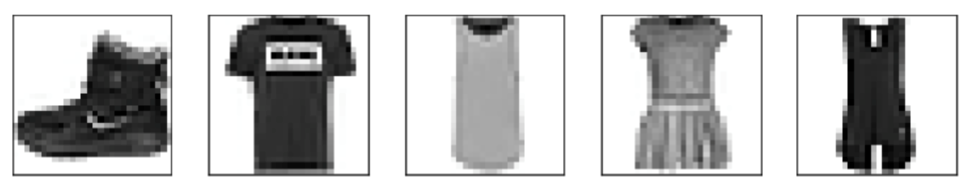
Figure 7. Five examples the 28 × 28 grayscale pixel images of the Fashion MNIST dataset, labelled as “Ankle boot”, “T-shirt/top”, “T-shirt/top”, “Dress” and “Dress” from left to right.